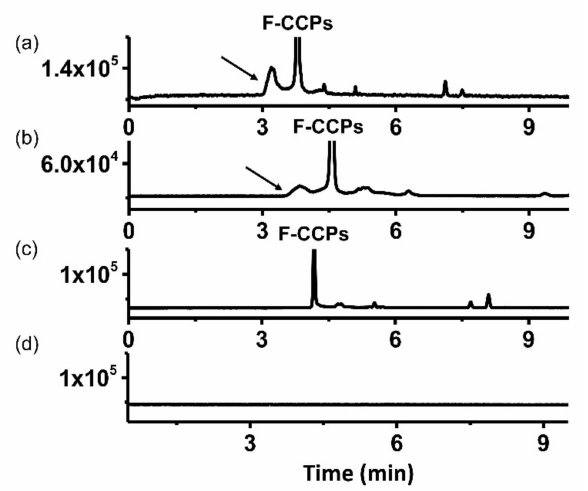
Figure 3. Electropherograms of immunocomplexes of fluorescent cyclic citrullinated peptides (F-CCP) with ( a ) anti-cyclic citrullinated peptides (CCP) antibodies in PBS, ( b ) anti-CCP antibodies in Fetal Bovine Serum, and ( c ) human IgG. ( d ) Electropherogram of patient samples without F-CCP treatment. Arrows indicate the peak from the immunocomplex of F-CCP and anti-CCP antibodies. Reproduced with the permission of